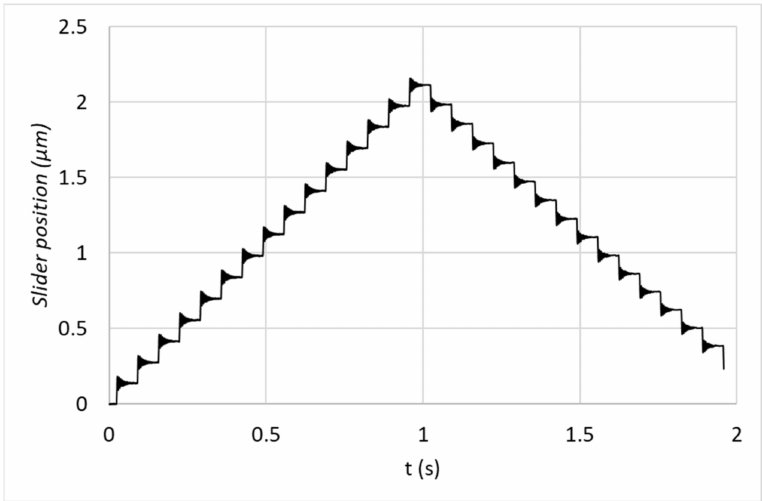
Figure 11. Slider position when single driving pulses are sent to the receiver coil to generate step movement 15 times and the following single steps again 15 times to make the slider return to its original position. Each single step can generate a mean step movement of about 140 nm in one direction and 125 nm in the reverse